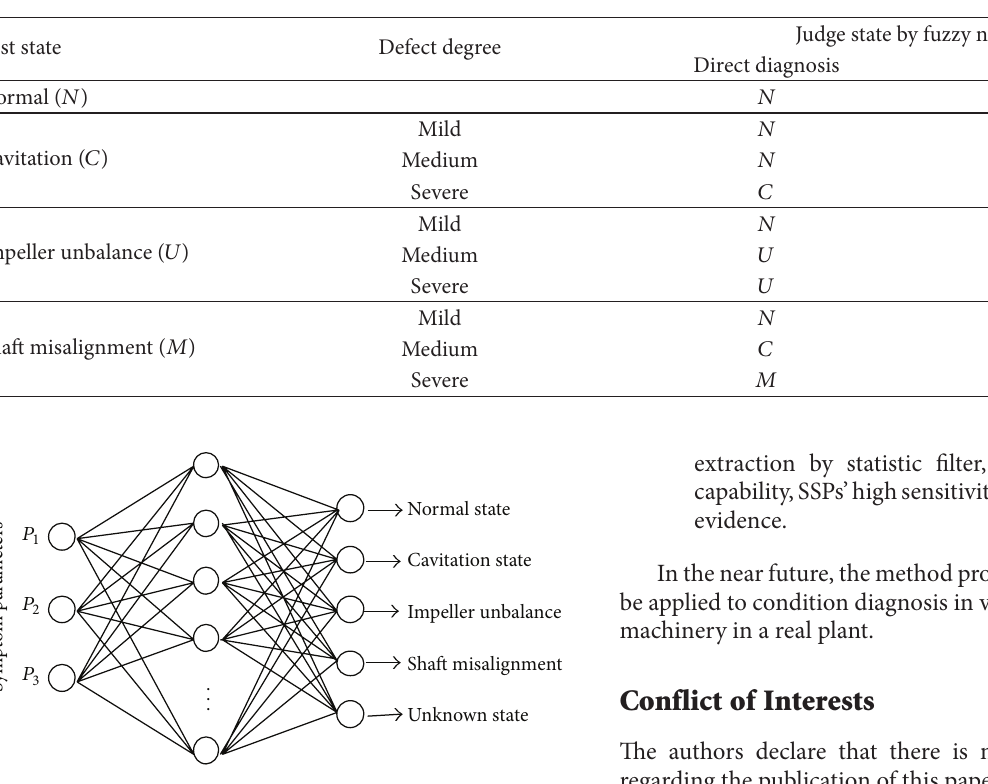
Table 7: The diagnostic results of various states with the defect degrees by fuzzy neural network.